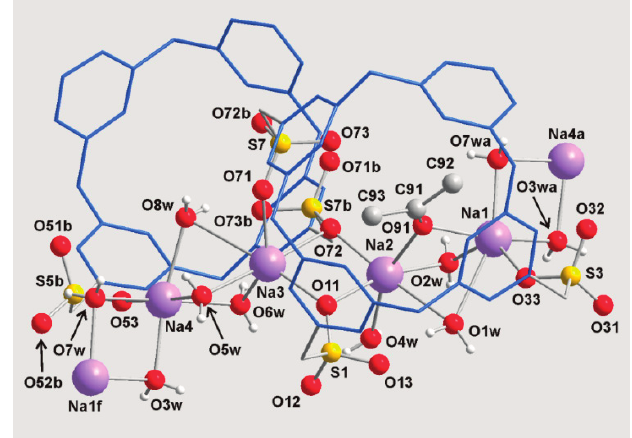
Figure 4. Perspective view of 2a . Resorcinarenyl units are showed in blue. C -butyl chains and non-water hydrogen atoms are omitted for clarity. Symmetry code: (a) x , y + 1, z ; (b) − x + 1, − y , − z + 1; (f) x , y – 1, z